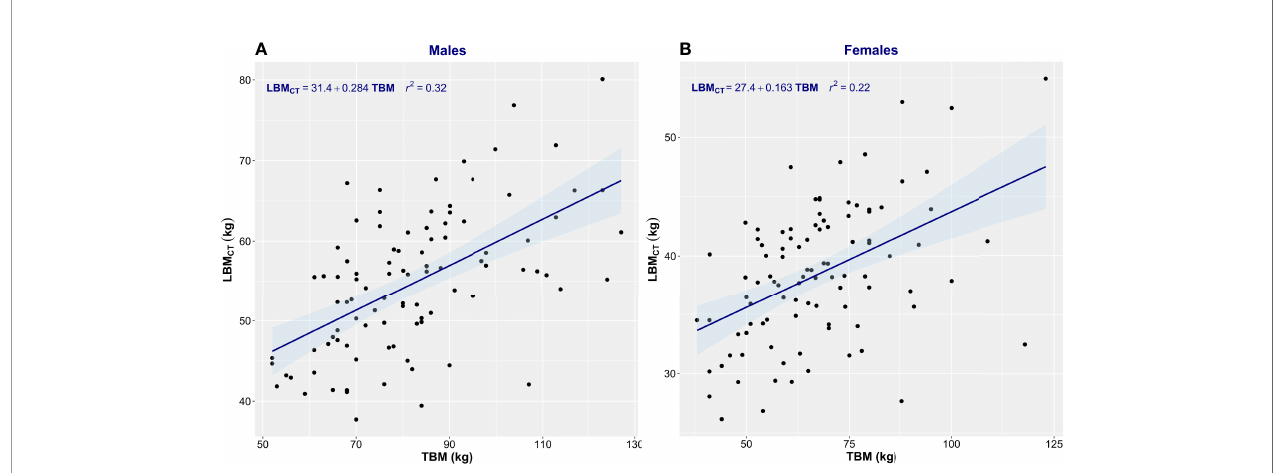
FIGURE 1 | Scatter plot of total body mass (TBM) vs. computed tomography – de fi ned lean body mass (LBM CT ). Men (A) and women (B) . The linear regression equation is provided in the top left of each graph, and it is plotted in blue. The shaded light-blue area represents the 95% con fi dence interval, and r 2 is the square of the Pearson correlation coef fi cient for TBM vs. LBM CT